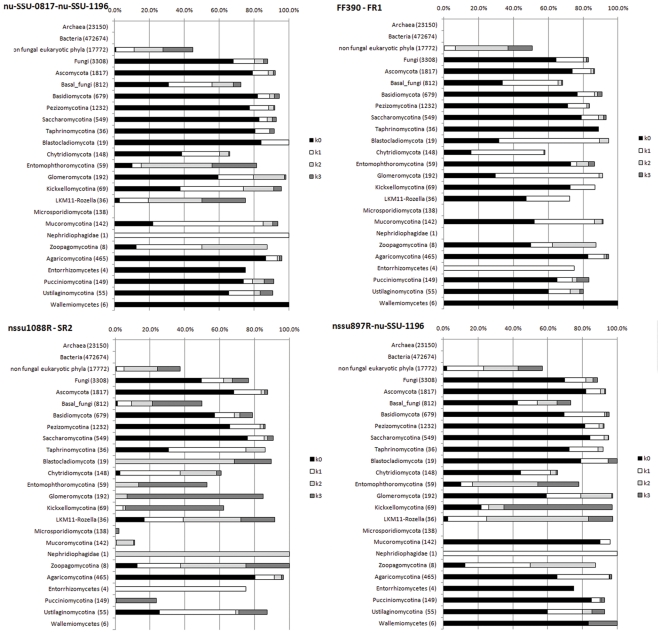

In silico comparison of the primer sets nu-SSU-0817/nu-SSU-1196, FR1/FF390, nssu1088R-SR2 and nssu897R-nu-SSU-1196 for their fungal-specificity.For each primer set, k mismatches (0 to 3) were allowed in the in silico analysis to test the specificity of the original primer set (k = 0) and its potential sequence improvement (k = 1 to 3). For each graph, each bar represents the hit frequency (%) of the primer set for the selected phylum with: k = 0: black, k = 1: dark grey, k = 2: white, k = 3: light grey. The number of sequences available for a phylum is indicated in brackets. Detailed hit frequencies are provided in Table S1.